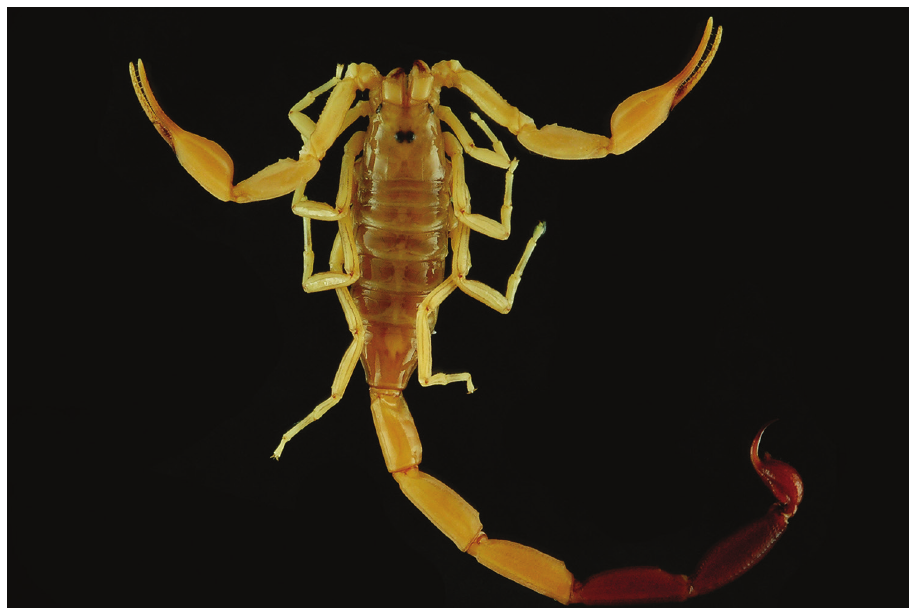
Figure 10. Tityus gasci , male holotype from Inini region (photo MNHN / E.-A. Genus Tityus C. L. Koch, 1836 Tityus ( Tityus ) gasci Lourenço, 1981 Fig. 10 References. Lourenço 1981, Lourenço 1983, Fet et al. 2000, Lourenço 2008. Material. Inini region, between Maripasoula and Antecume-Pata, one male (holo- type), MNHN-RS-7921, J.P. Gasc coll., VII-IX/1972, leg., 1975. Diagnosis. Species of medium size compared to the average size of the other species of the genus, with a total length of 63.4 mm for the male holotype. General coloration yellowish. Carapace yellowish with some shades of brownish; eyes surrounded with black pigment. Tergites yellowish with confluent pale yellow zones on tergites, making an incomplete rhomb on the tergite VII. Sternites dark yellow with a lighter triangular area on the posterior part of sternite V; sternum, genital operculum and pectines yel- low ochre. Metasomal segments I to III yellowish, IV and V dark reddish. Vesicle dark reddish with basis of aculeus reddish yellow and tip of aculeus reddish black. Cheli- cerae yellowish with reddish teeth. Pedipalp femur and patella yellowish; chela reddish yellow with reddish fingers; base of movable finger dark, almost black. Legs yellowish with blackish pigment on carinae. Anterior margin of carapace moderately emargin- ated; carapace carinae weakly developed; anterior median carinae weak; intercarinal spaces weakly granular, almost smooth. Tergites almost smooth with only few granules on posterior area; tergites I-VI with one very weakly marked median carina; tergite VII